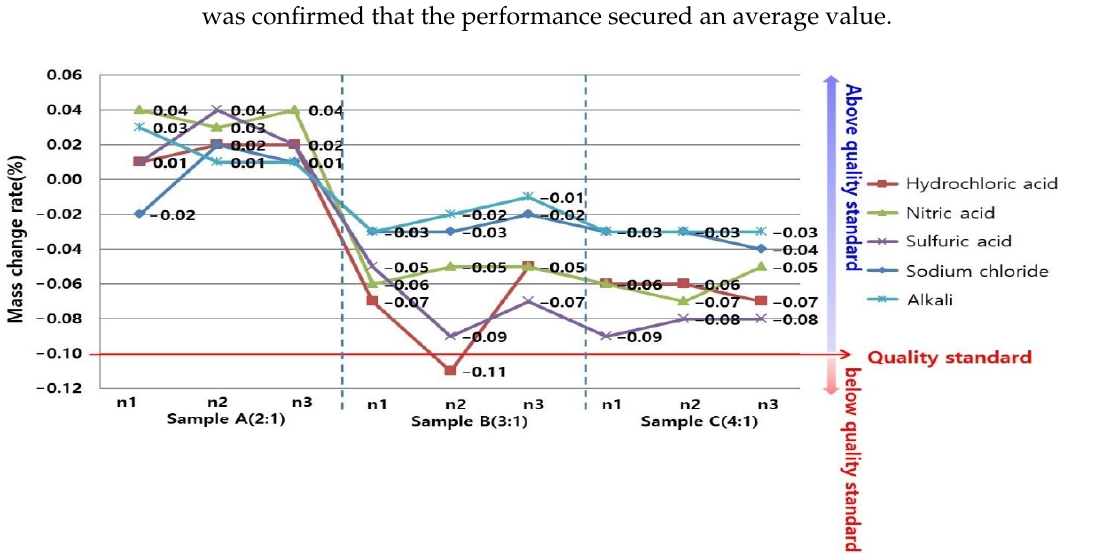
Table 7. Temperature safety by sample of W-SPRG.